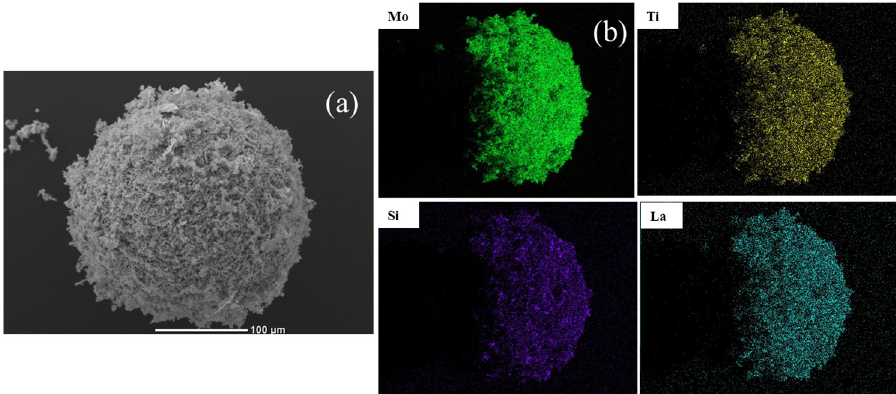
Figure 4. ( a ) SEM image and ( b ) corresponding EDS mappings of an FD-POEM MoSiBTiC-La 2 O 3 particle.